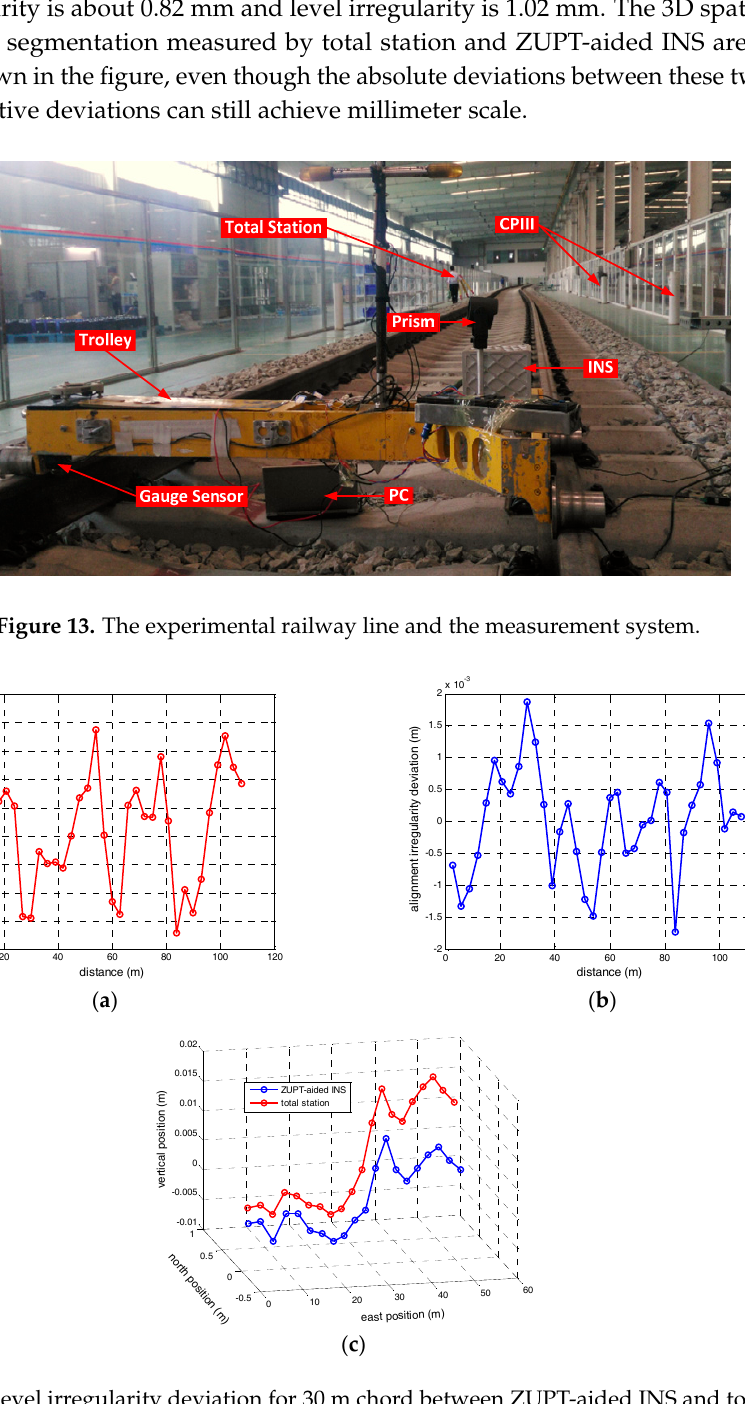
( b ) Figure 15. ( a ) Level irregularity measurement repeatability for 30 m chord; ( b ) Alignment irregularity measurement repeatability for 30 m chord. The irregularity differences at the same railway track points between different runs indicate the repeatability of the measurement. The results of statistic deviation of alignment and level irregularities are listed in Table 1. As Table 1 shows, the standard deviations of differences in